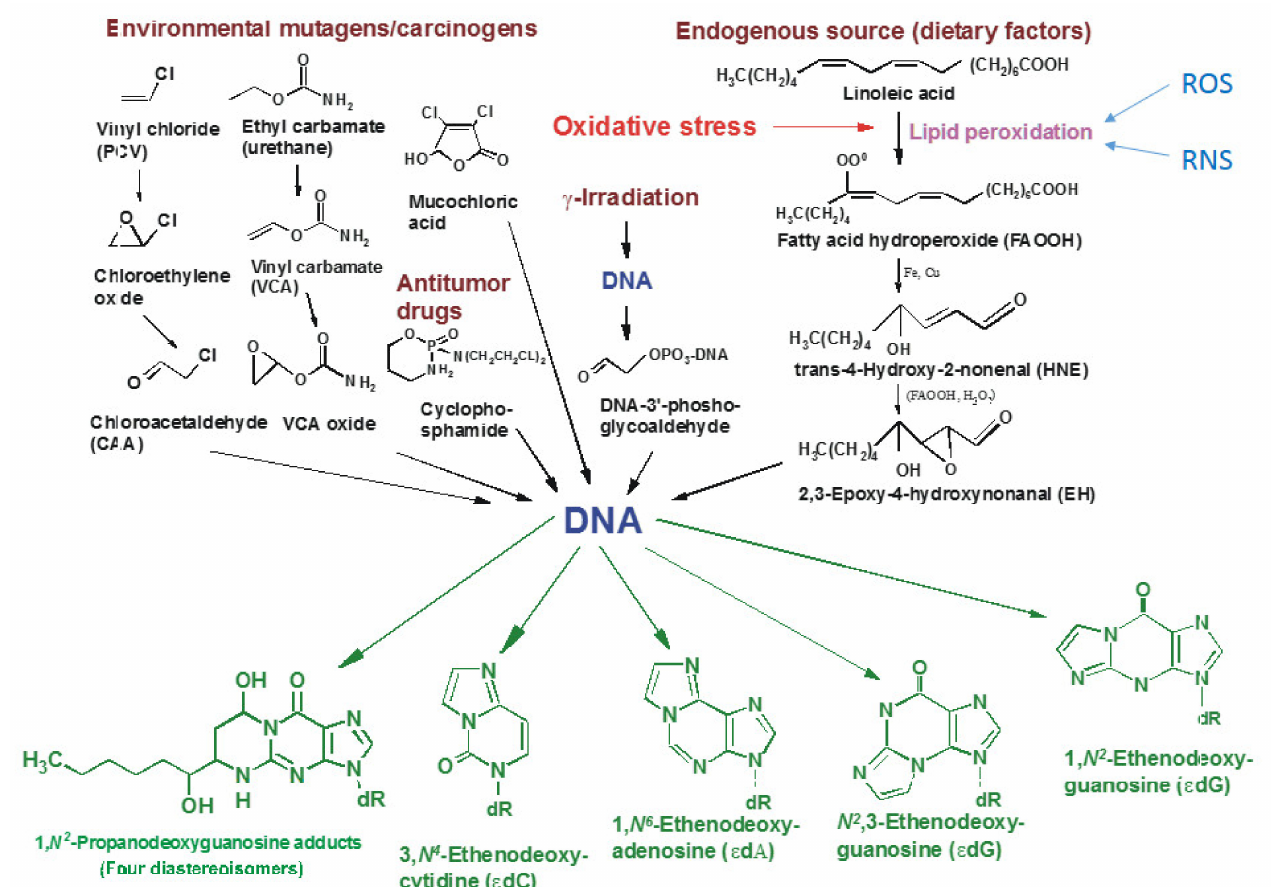
Figure 1. DNA damaging internal and external factors causing formation of etheno and propano base